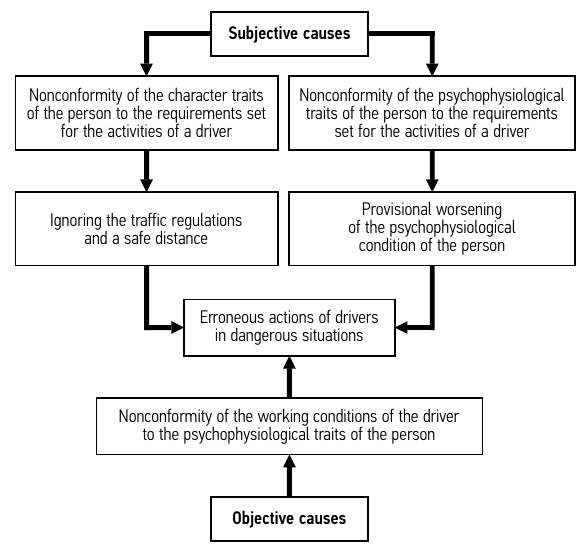
Fig. 1. The scheme of psychological preconditions for erroneous actions of drivers in dangerous